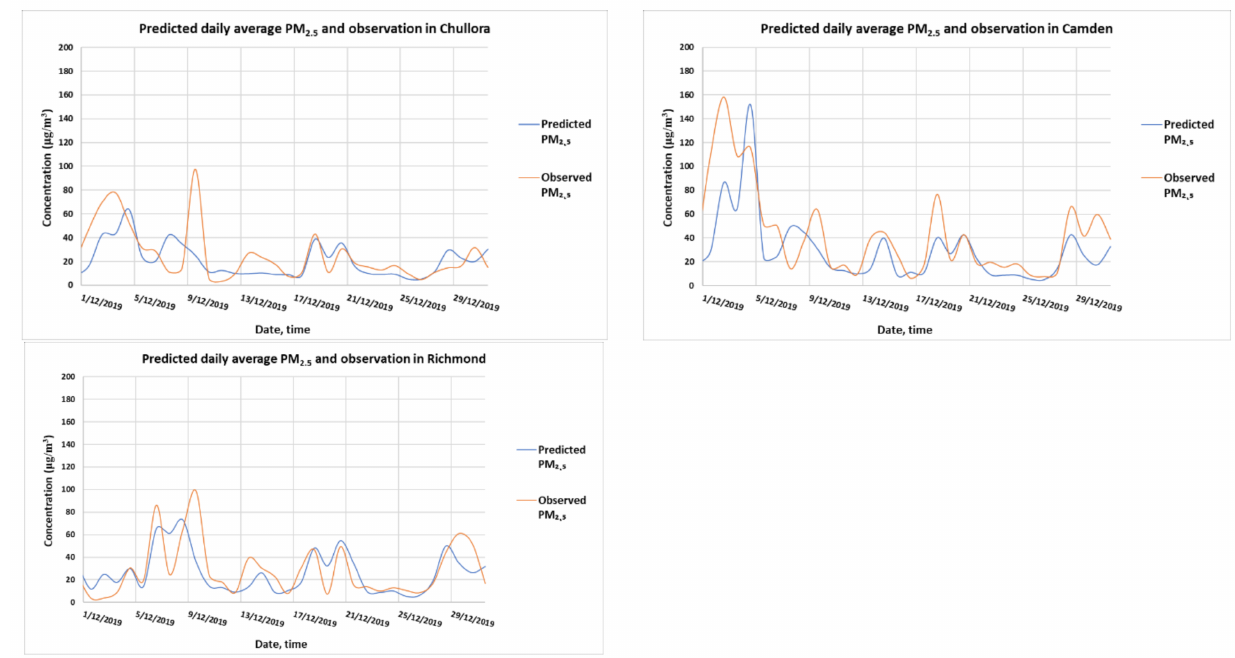
Figure 10. Predicted and observed daily average PM 2.5 concentrations in Wyong, Bringelly, Port MacQuarie, Beresfield, Earlwood, Liverpool, Chullora, Camden and Richmond.